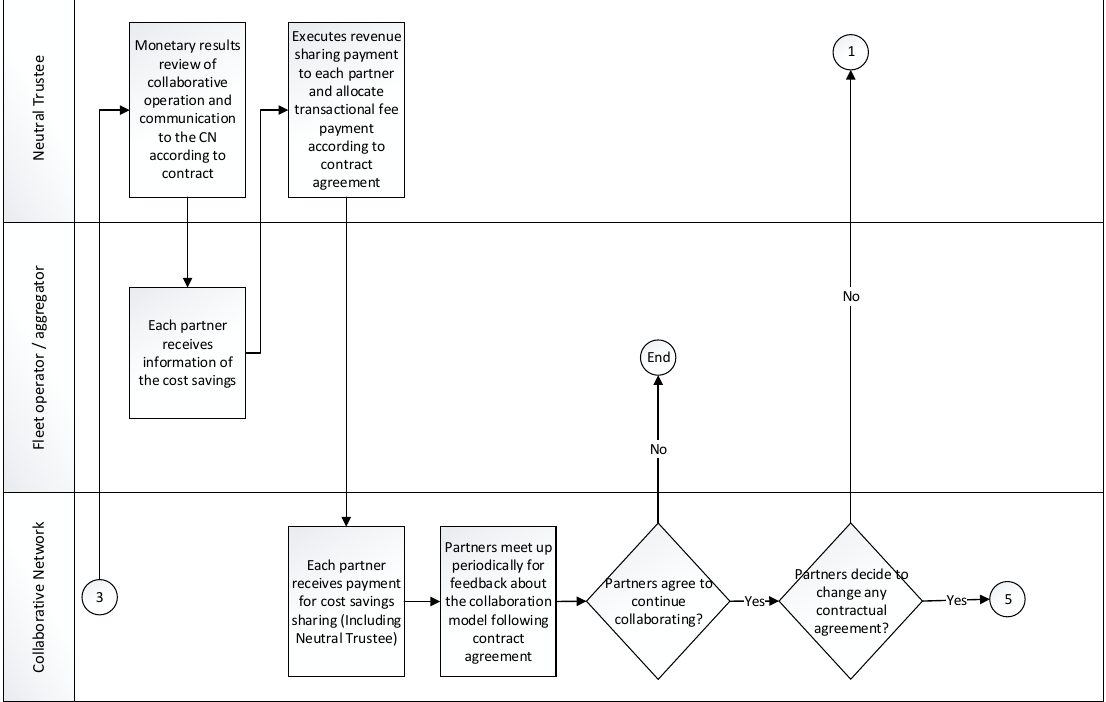
Figure 13. Workflow for proposed FSL business model—Management of unexpected events. Logistics 2018 , 2 , x FOR PEER REVIEW